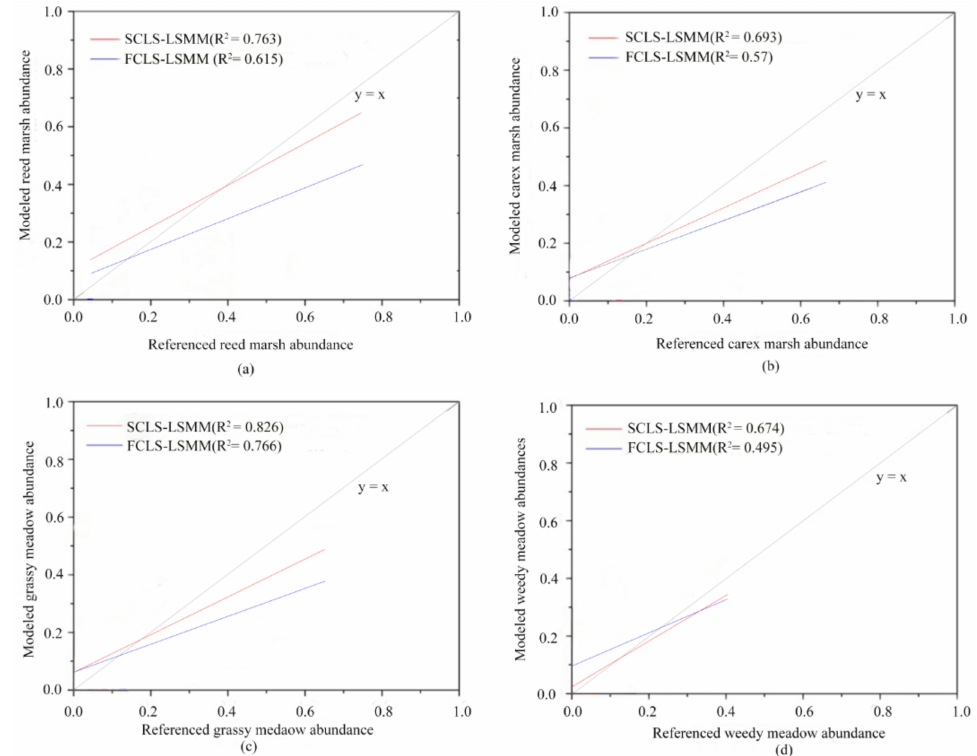
Figure 2. The field gauged spectral curves of four typical vegetation communities.